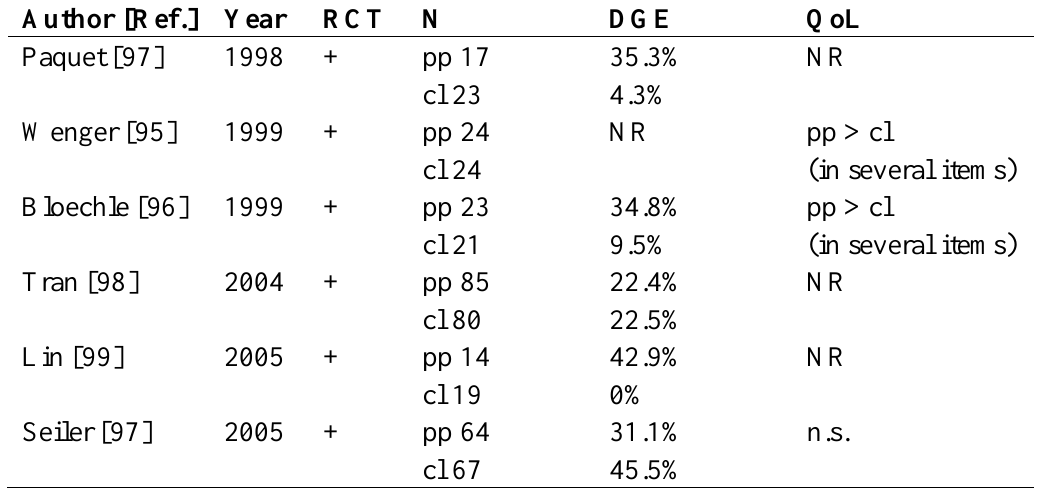
Table 1. Currently available randomized controlled trials on pylorus-preserving vs . classical Whipple